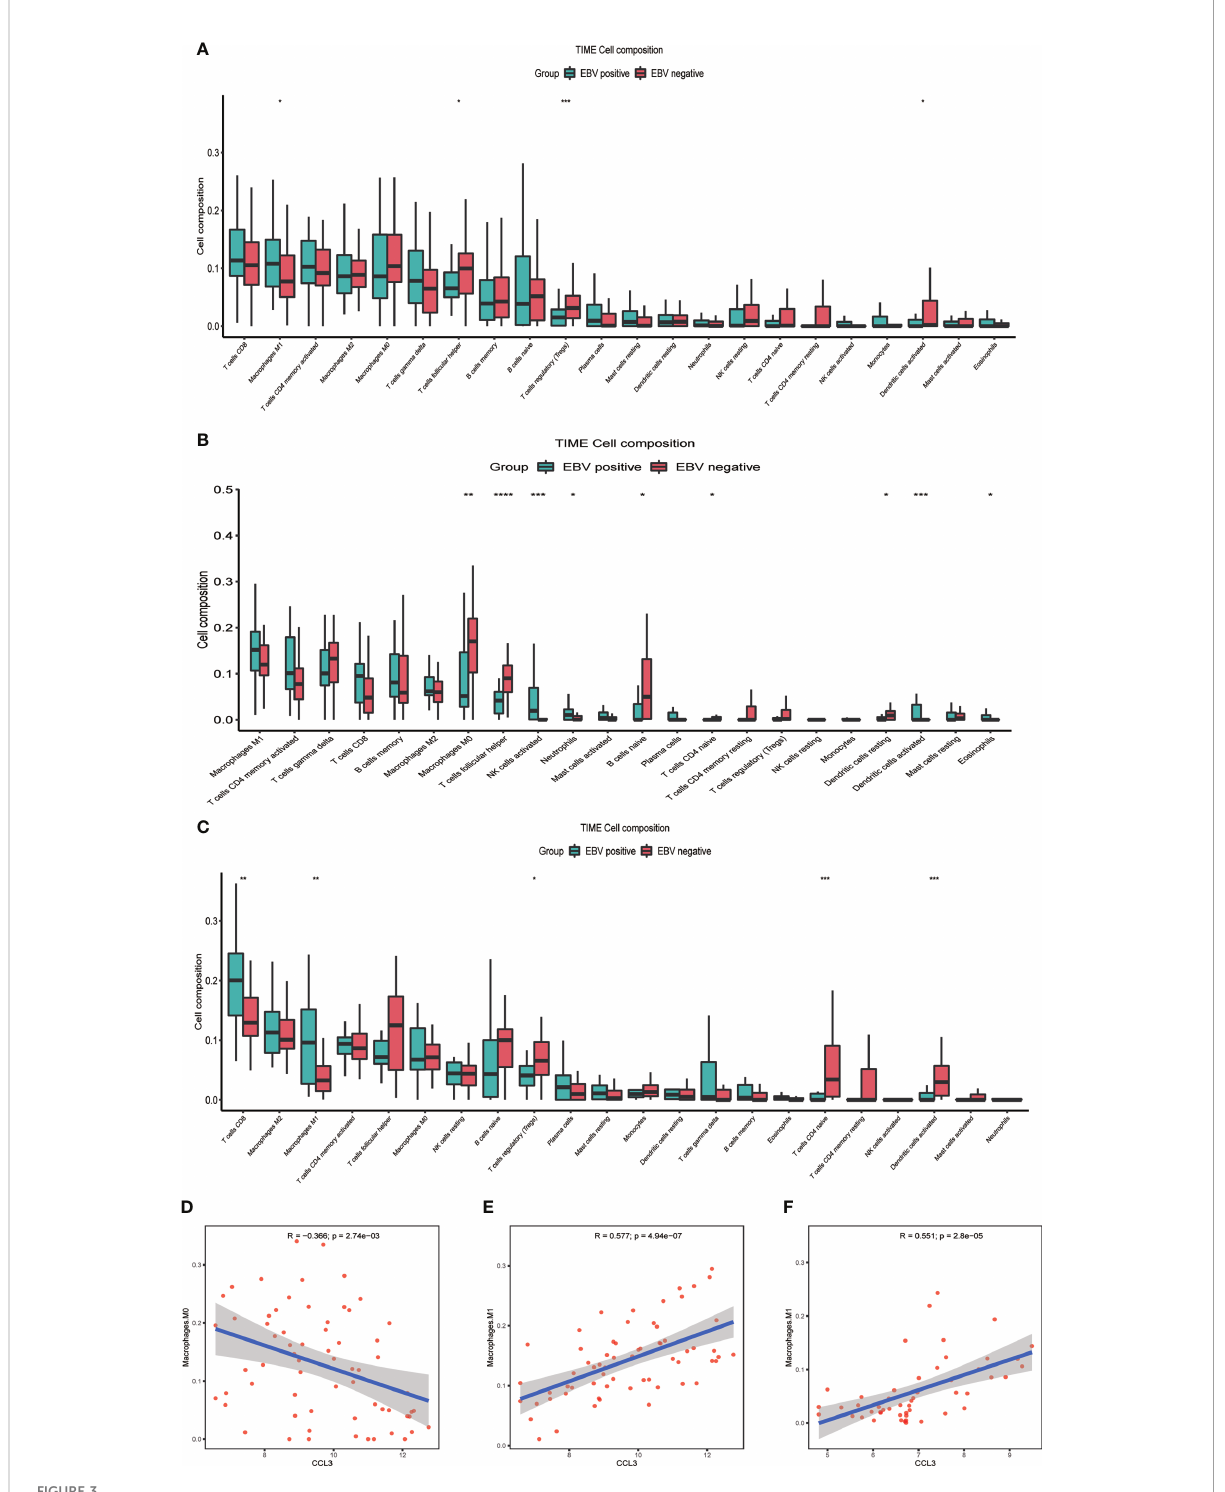
FIGURE 3 The difference between immune cell fractions between EBV+ and EBV- group. (A) The box plot shows the differences of in fi ltration of 22 kinds of immune cells between two groups in lymphoma samples. (B) The box plot shows the differences of in fi ltration of 22 kinds of immune cells between two groups in NHLs. (C) The box plot shows the differences of in fi ltration of 22 kinds of immune cells between two groups in HLs. (D, E) Correlation of CCL3 with in fi ltration of macrophage in NHLs. (F) Correlation of CCL3 with in fi ltration of macrophage in HLs *<0.05, **<0.01, ***<0.001,